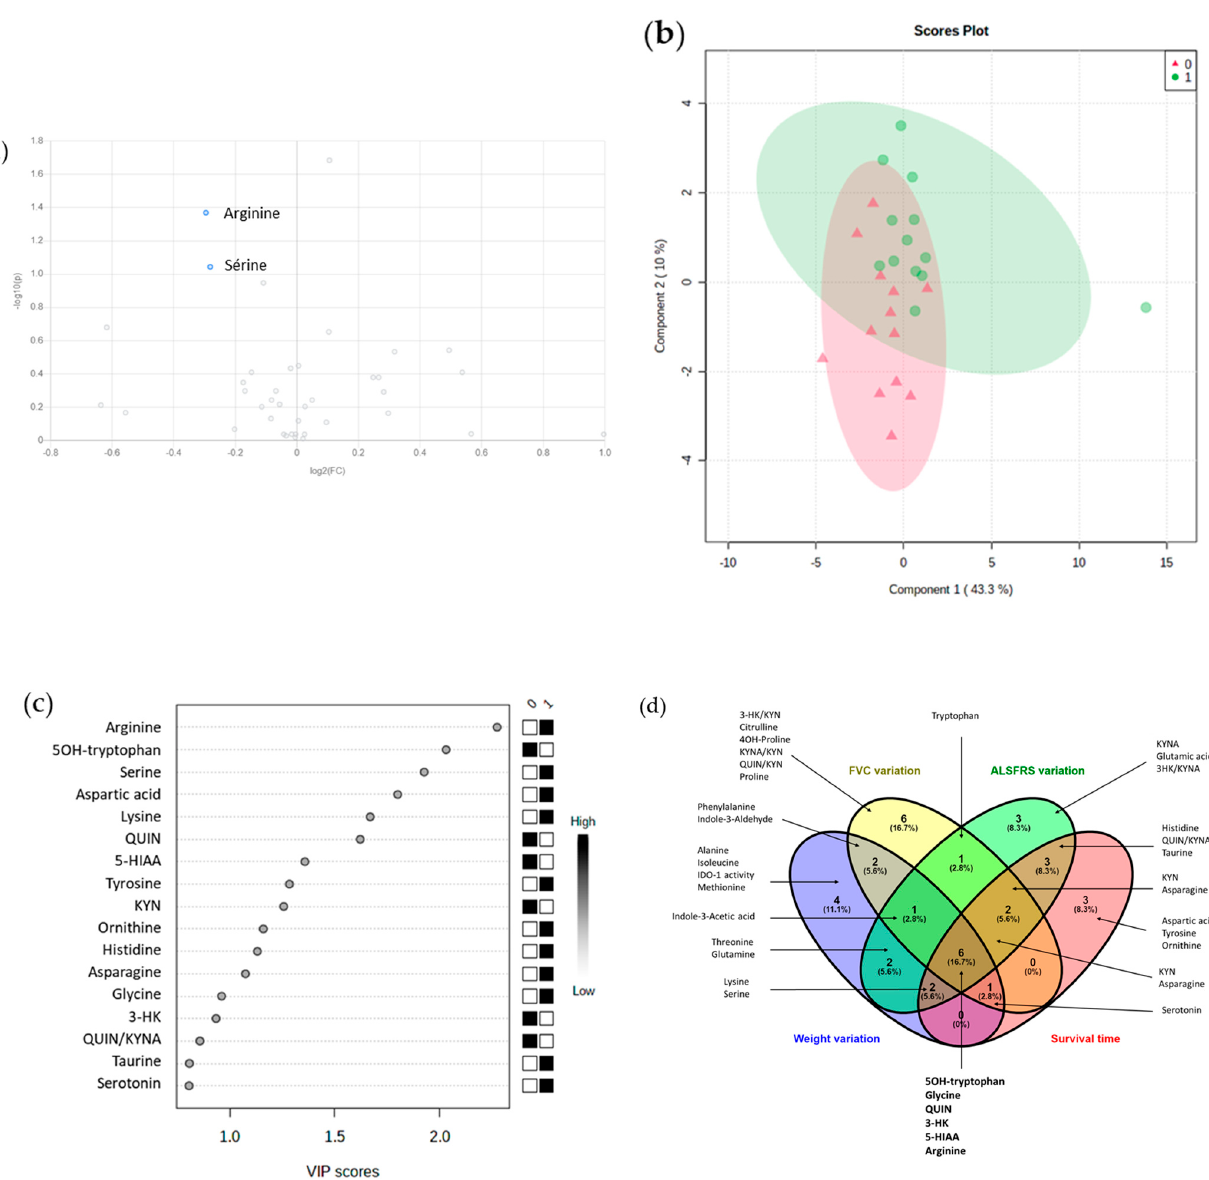
Figure 3. Multivariate analysis of CSF amino acids and tryptophan catabolism metabolites for prognostic biomarkers of ALS. Only figures showing results for the duration of disease are represented on panels ( a ), ( b ), and ( c ). Two groups were obtained according to the median duration until death (22.6 months). ( a ) Volcano plot representing the most important features in univariate analysis. Blue dots indicated a decrease of the feature in patients who died within 22.6 months after the first symptoms; ( b ) scores plots of the PLS-DA model. Red triangles (0) represent ASL patients who died within 22.6 months after the first symptoms and green dots (1) represents patients who died after 22.6 months; ( c ) important features (VIP > 0.8) identified by PLS-DA. The boxes on the right indicate the relative concentrations of the corresponding metabolite in each group. ( d ) Venn diagram representing metabolites with a VIP > 0.8 with PLS-DA models between ALS patients according to variation of weight, FVC and ALSFRS-r scores over a year, and survival